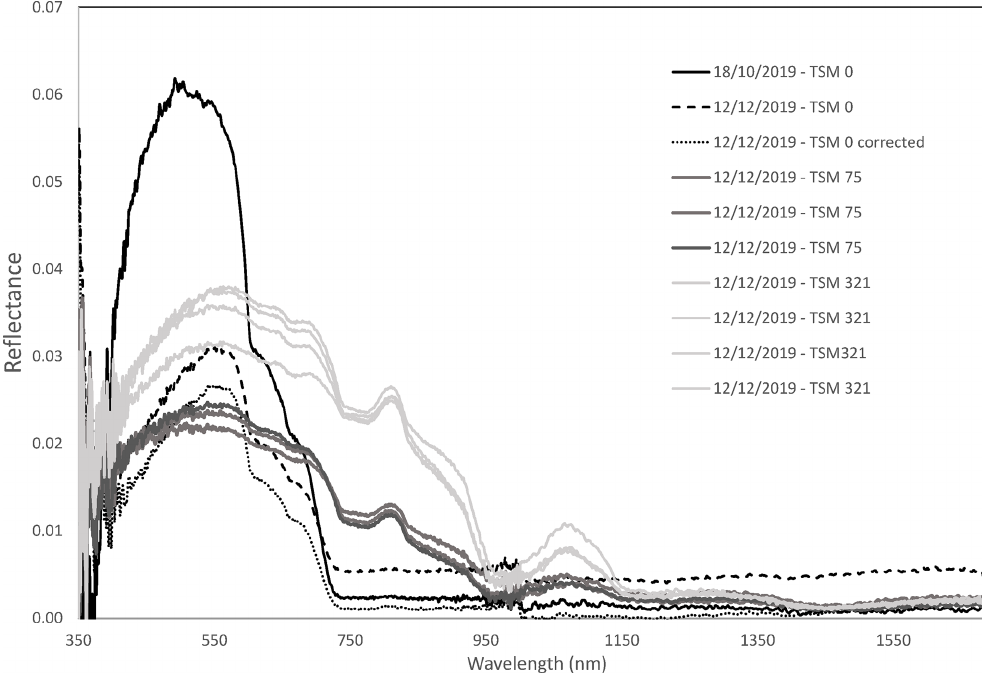
(NIR) and SWIR, the water from 12 December has a clear reflectance signal, which is not expected because of strong pure water absorption. The reason for the difference in re- flectance between both dates can be some remaining sed- iments in the water and some dust floating on the surface